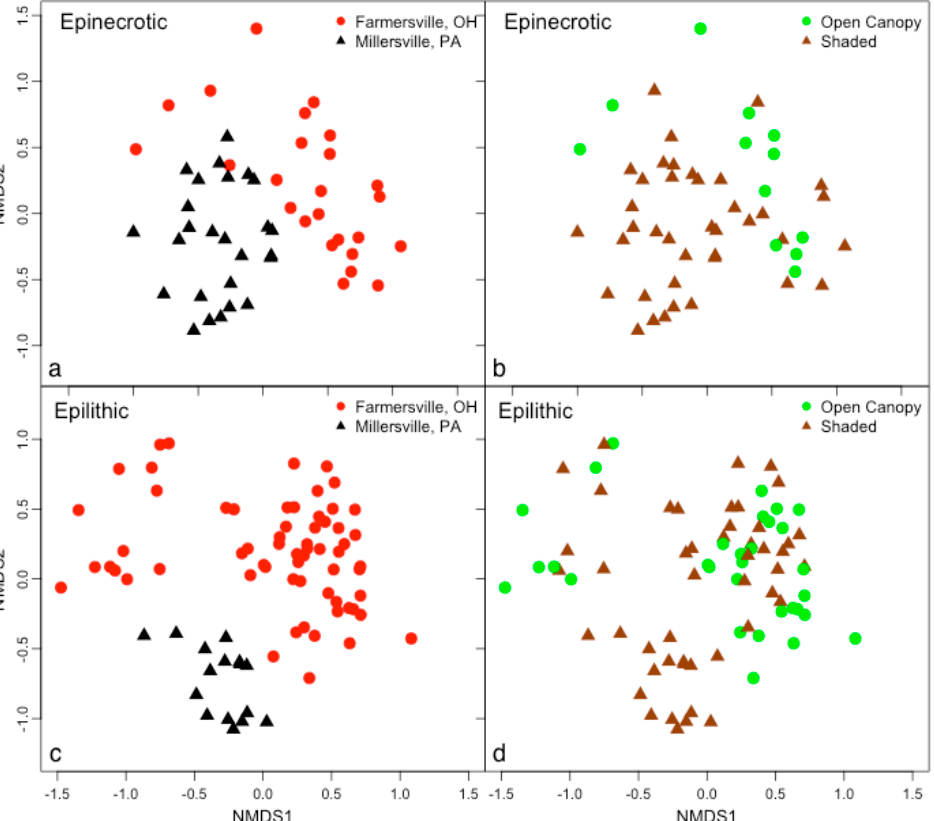
Figure 2. Bacteria communities were separated into ( a ) and ( b ) epinecrotic (3-D, R 2 = 0.97, stress = 0.17) and ( c ) and ( d ) epilithic (3-D, R 2 = 0.98, stress = 0.14) biofilms and community structure was visualized using nonmetric multidimensional scaling. ( a ) and ( c ) Location of study significantly influenced community structure of both biofilm types as determined by PERMANOVA, but only epilithic biofilms were significantly affected by ( b ) and ( d ) canopy.